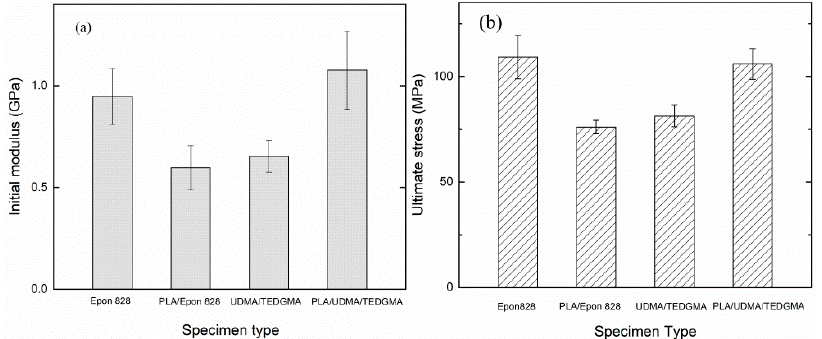
Figure 6. Mechanical properties of different specimens: ( a ) bar chart shows initial modulus of 4 types of specimens and their margins of error; ( b ) bar chart shows ultimate stress of 4 types of specimens and their margins of error.